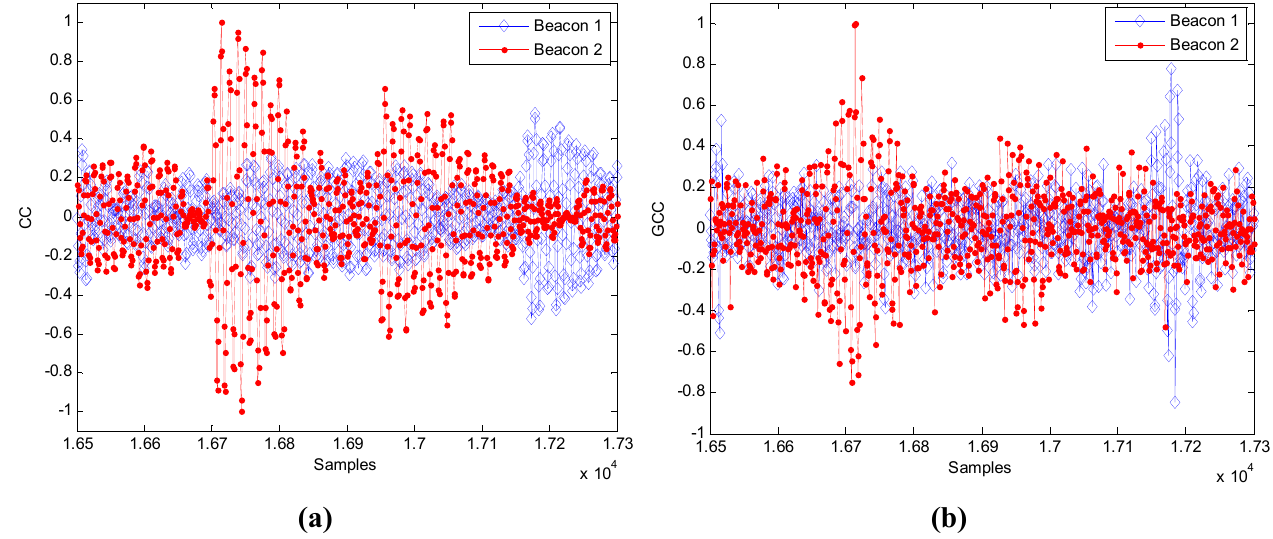
Figure 13. Beacon detection in the position 1 with real signals ( m = 1) applying: (a) CC and (b)